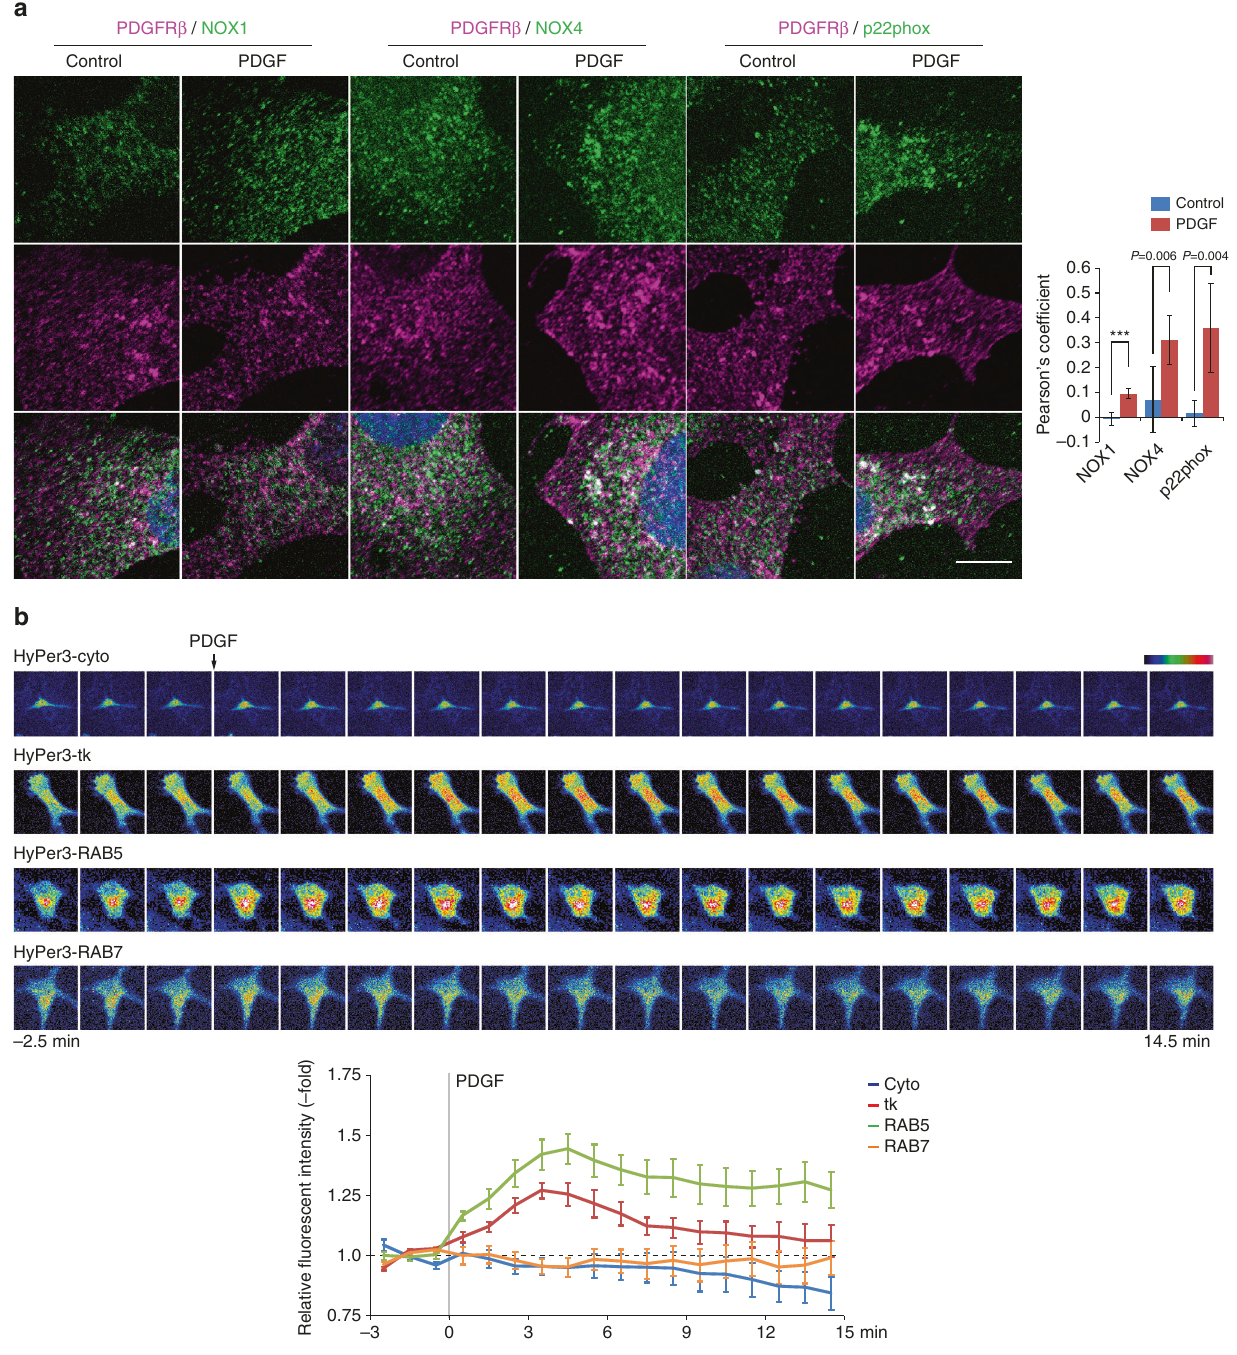
Fig. 5 PDGF evokes redoxosome formation. a Serum-starved Swiss 3T3 cells were stimulated with PDGF-BB (50 ng ml − 1 ) for 5 min, then immunostained with anti-PDGFR β ( magenta ) and the indicated anti-NOX component antibodies ( green ). Representative images are shown for each condition from one of two independent experiments. Nuclei were stained with DAPI ( blue ). Scale bar : 10 μ m. The graph shows the average value of Pearson ’ s coef fi cient for PDGFR β and the indicated NOX components with or without PDGF-BB stimulation ( n = 1 ROI from each of 10 cells) *** P < 0.0001; two-tailed Welch ’ s t - test. b Serum-starved Swiss 3T3 cells expressing cytoplasmic HyPer3 (HyPer3-cyto), plasma membrane-targeted HyPer3 (HyPer3-tk), RAB5-fused HyPer3 (HyPer3-RAB5) or RAB7-fused HyPer3 (HyPer3-RAB7) were subjected to live-cell, time-lapse imaging. Top panels : Fluorescence intensity (pseudo- colored) of each HyPer3 construct shown at 1 min intervals. PDGF-BB (50 ng ml − 1 ) was added ( arrow ) after the third scan. Bottom panel : Graph shows the means of the relative fl uorescence intensities of individual cells ( n = 7 cells from each independent time-lapse experiment), setting the average of the fi rst three time-points to 1 ( bottom ). Error bars represent